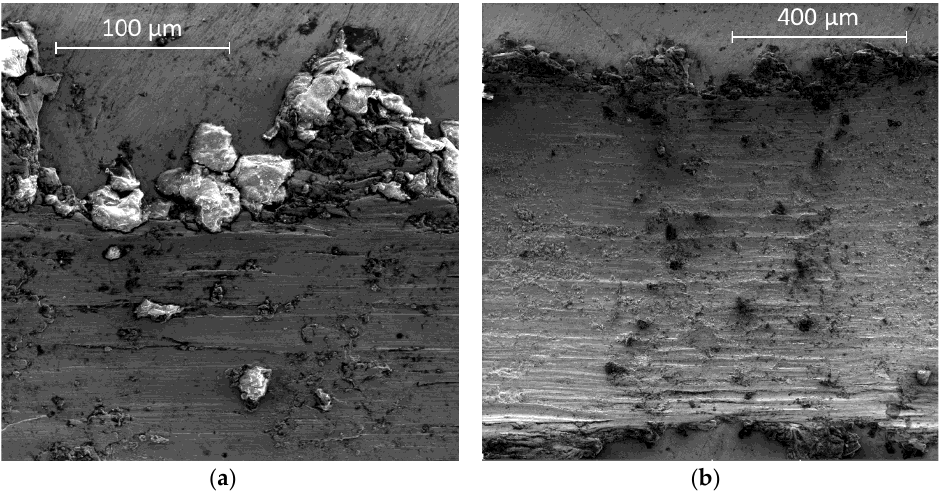
Figure 8. SEM of the non-textured wear track of Ti6Al4V sample; ( a )750×, ( b )200×.